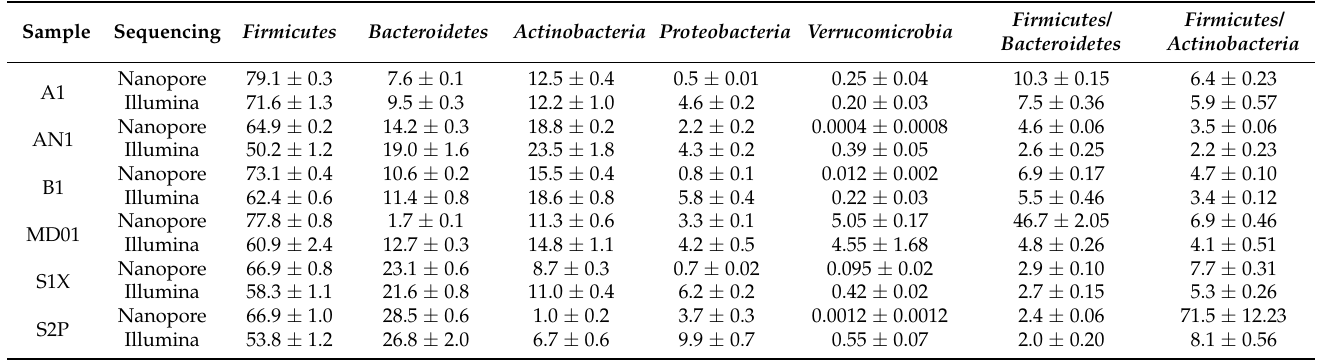
Table 3. Relative abundance (% ± SD) of the dominant phyla and their ratios in the faecal samples.